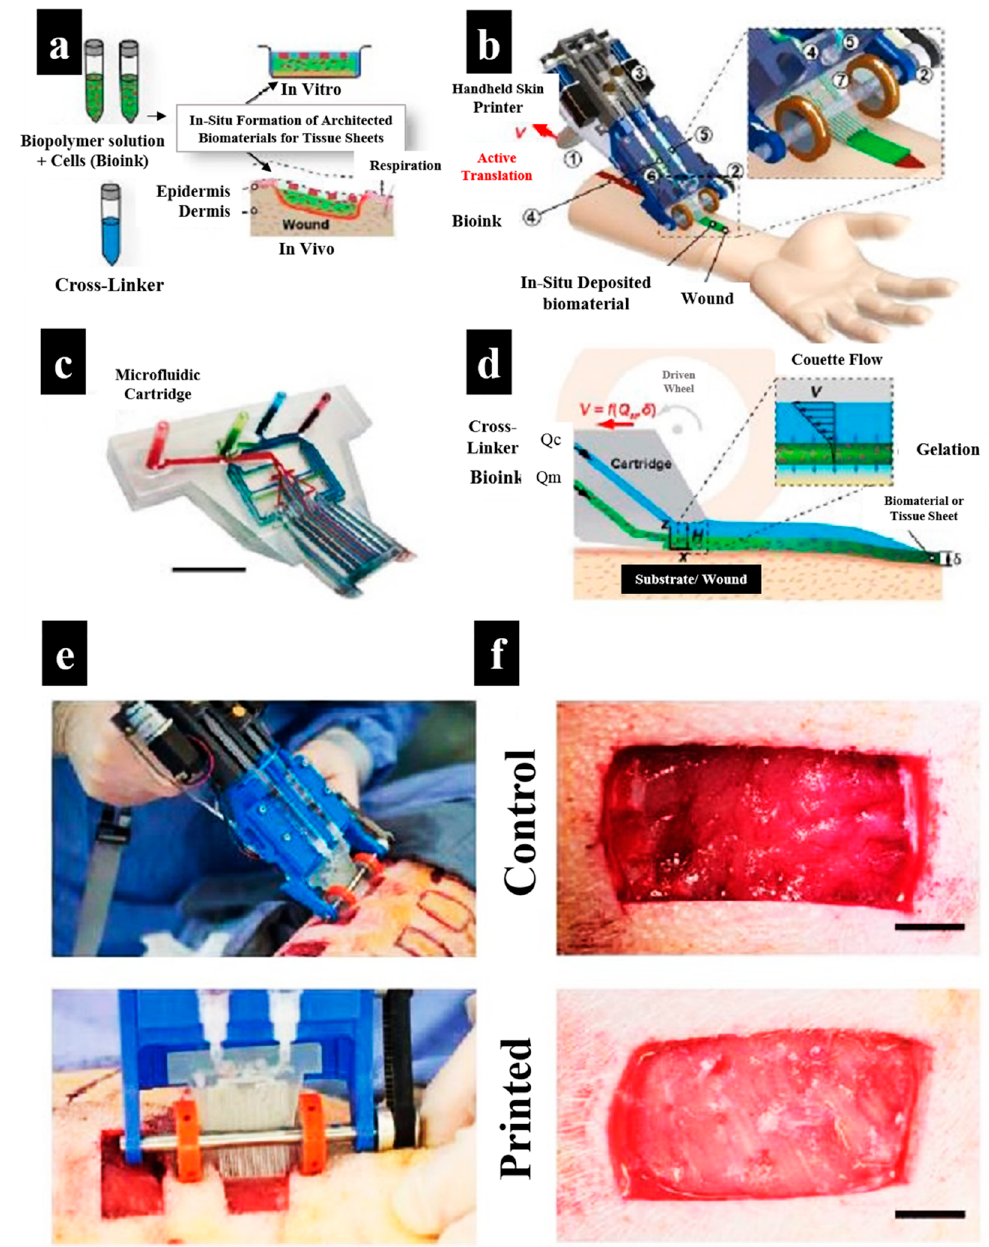
Figure 5. Handheld skin printer. ( a ) Schematic diagram demonstrating the working principle of handheld bioprinter. One or several bioink solutions (green color), containing premixed biomaterials and cells are arranged. The handheld bioprinter transforms bioinks into homogenous or architected biomaterial sheets or tissues directly within a culture dish or a wound site. ( b ) Rendered image of handheld bioprinter. A handle (1) enables positioning above the target surface or wound. A stepper motor, pulley, and drive mechanism (2) define the deposition speed, V. Two on-board syringe pump modules (3) control the dispensing flow rates for bioink (4) and crosslinker solution (5). 3D printed microfluidic cartridge (6) for the spatial organization of solutions and sheet formation. ( c ) Photograph of 3D printed microfluidic cartridge. Scale bar 10 mm. ( d ) Schematic side-view image demonstrating sheet formation between the moving microfluidic cartridge and the deposition surface or wound. ( e ) Representative photograph showing in situ deposition of δ = 250 µm thick fibrin–hyaluronic acid/collagen sheet on top of a full-thickness excisional porcine wound using a handheld skin printer. (top) Close-up view of sheet formation within wound bed with a 2 cm microfluidic cartridge (bottom) ( f ) (Control, not printed) on day 0 and printed 5 min after in situ formation of biomaterial sheet [108].